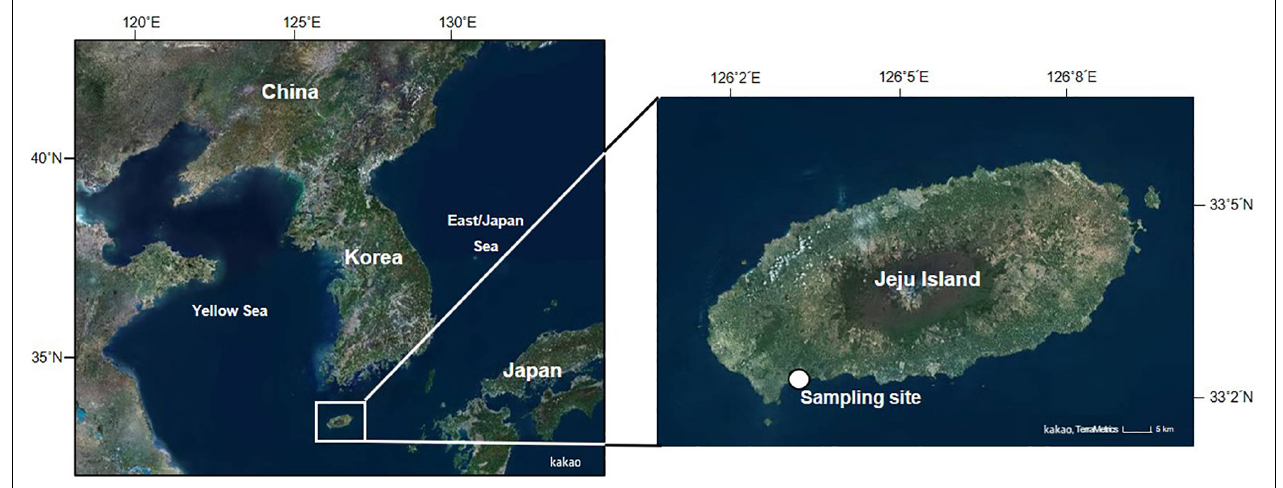
FIGURE 1 | Map showing the location of the mussel sampling sites. Mytilisepta virgata were collected from the rocky intertidal area of Hwansun, located on the southern coast of Jeju